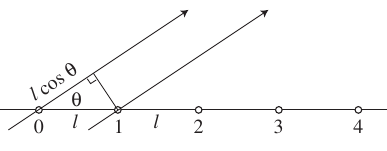
Figure 1: The notation related to a linear antenna